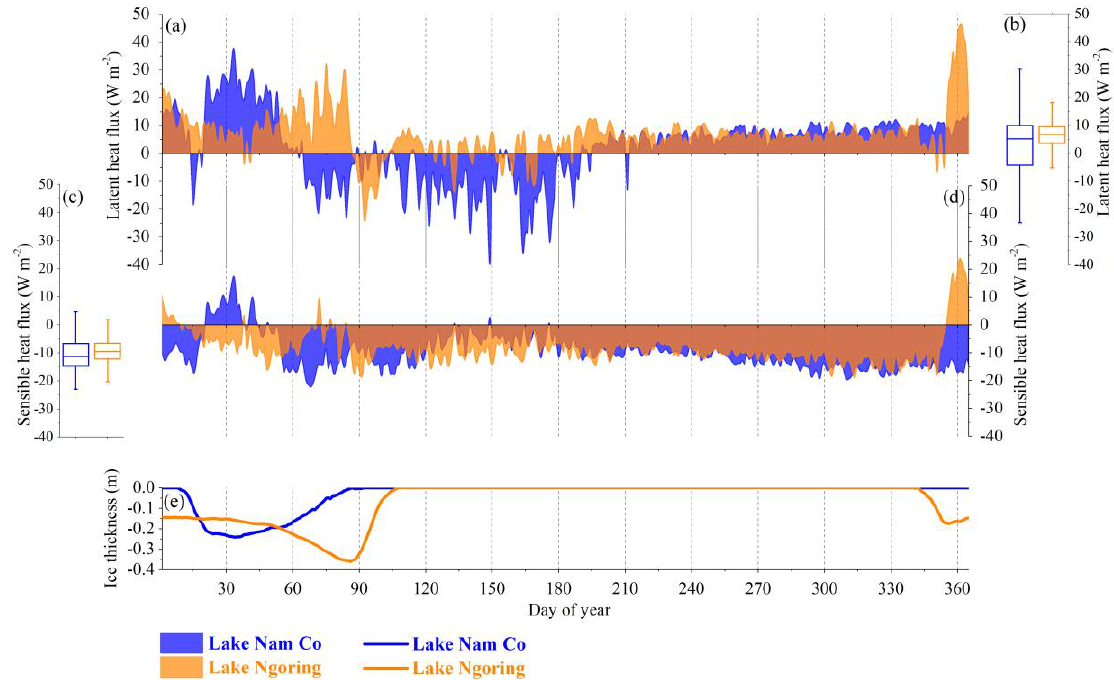
Figure 10. Comparison of changes in the differences, when the air temperature rises by 0 ◦ C and by 3.5 ◦ C (the latter minus the former), for H, LE and ice thickness for Lake Nam Co and Lake Ngoring (averaged from January 2012 to December 2016): (a, b) LE, (c, d,) H, and (e) lake ice thickness.